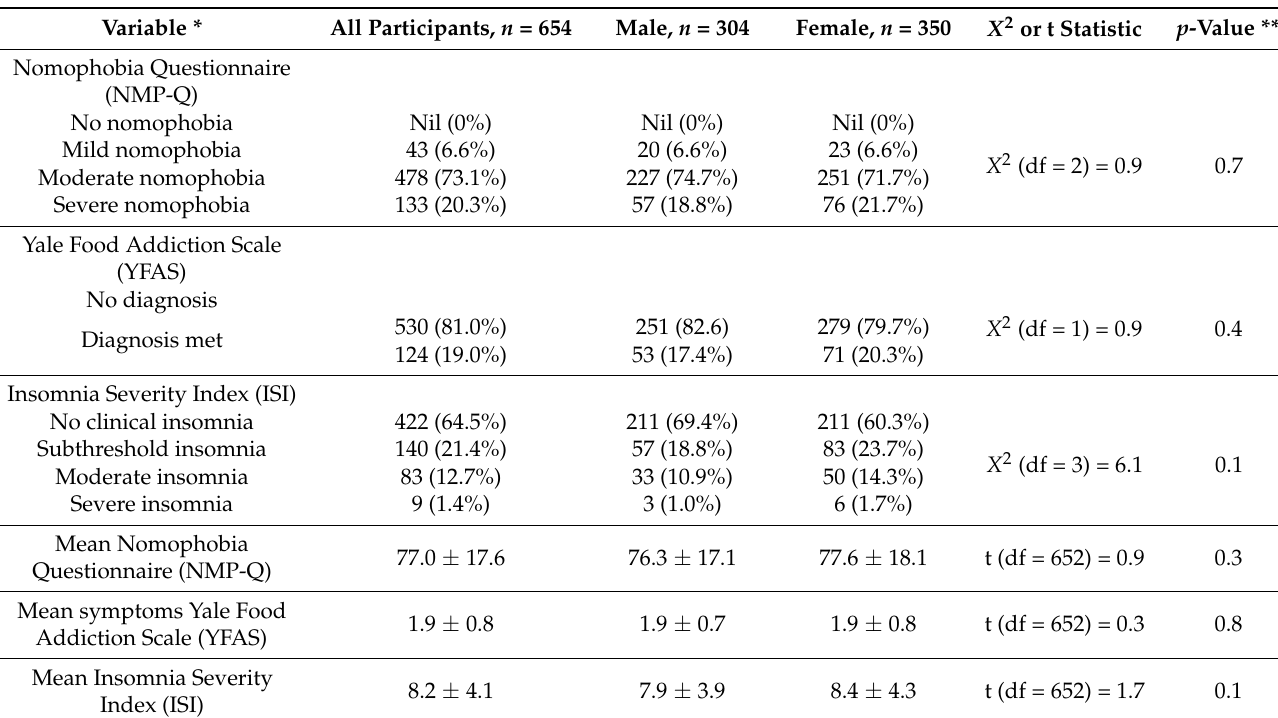
Table 2. Results of study participants Nomophobia Questionnaire (NMP-Q), Insomnia Severity Index (ISI), and Yale Food Addiction Scale (YFAS).